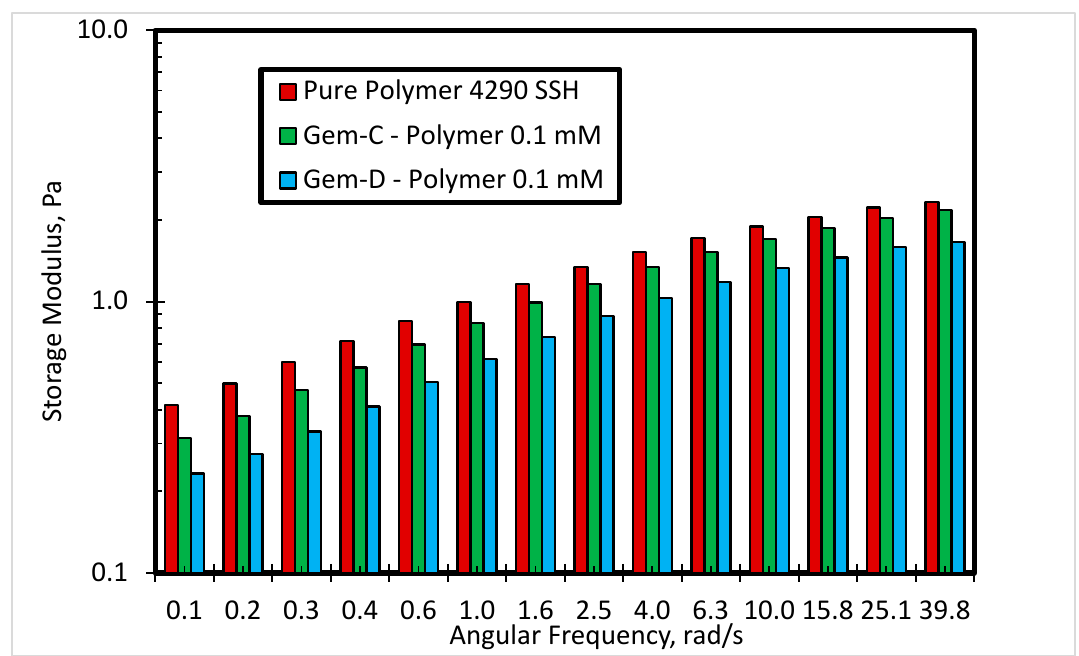
Figure 12. The storage modulus of 4290 SSH polymer with Gem-C and Gem-D at 0.1 mM concentration.